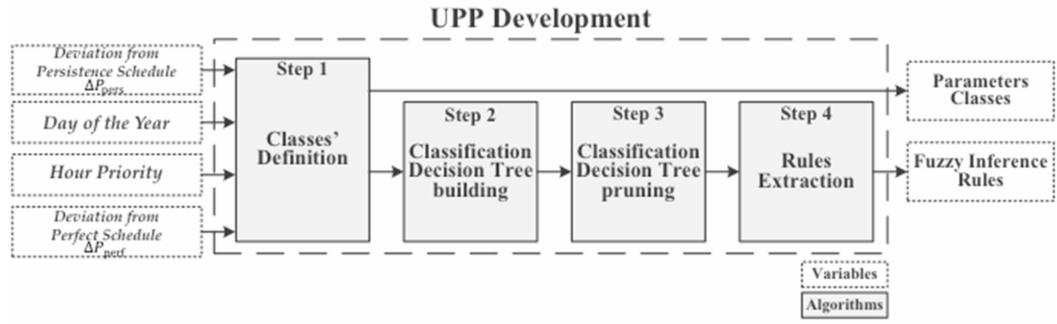
Figure 3. Uncertainty post-processing (UPP) development